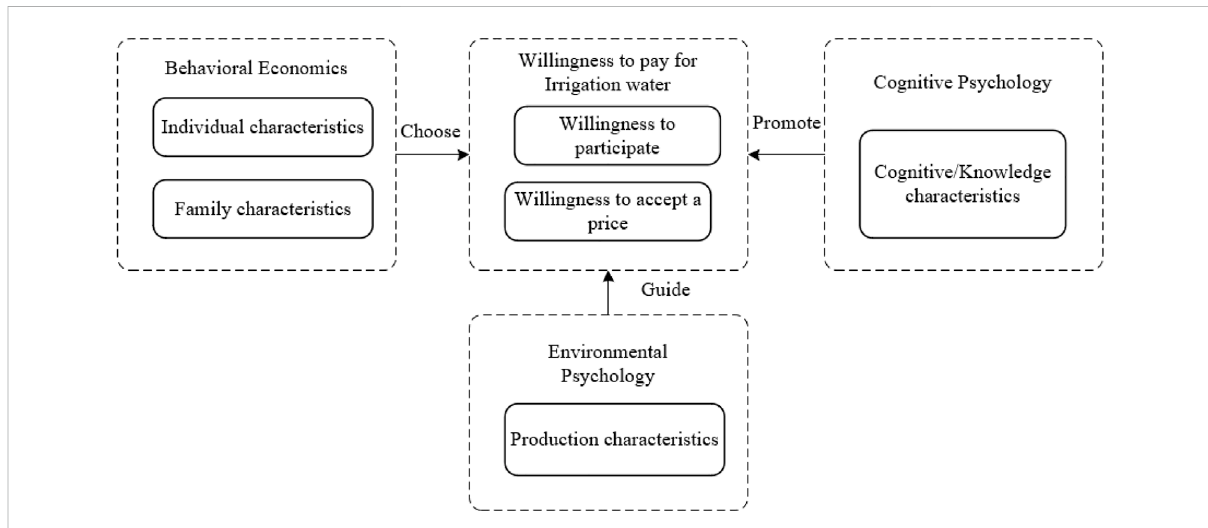
FIGURE 1 Theoretical analysis framework of the